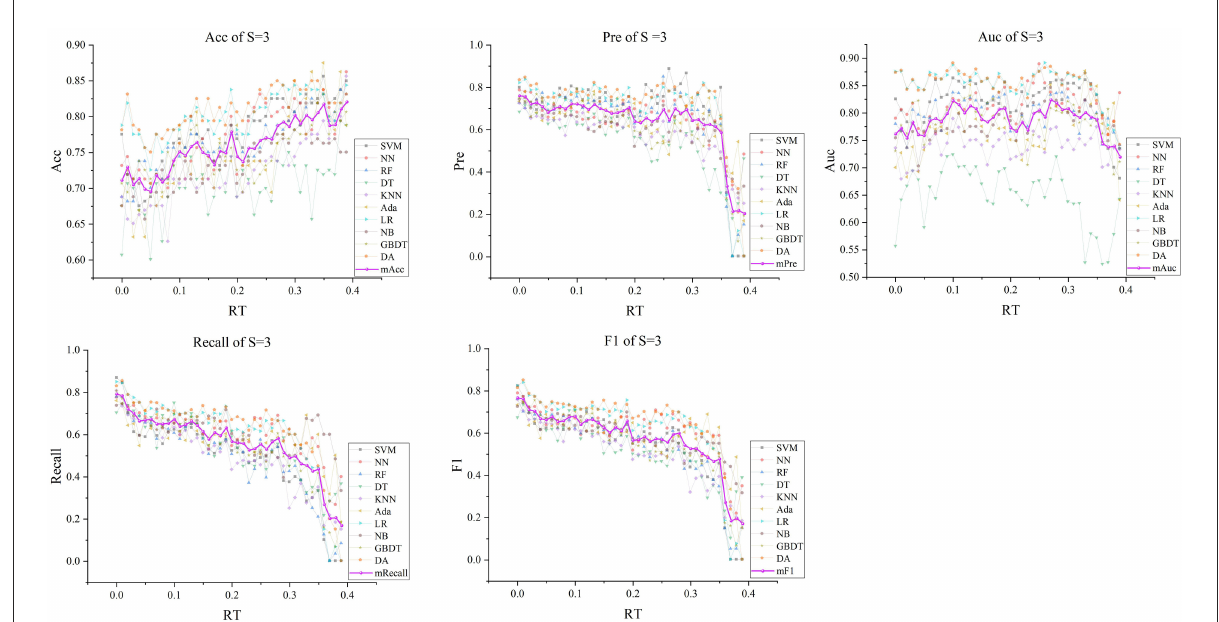
FIGURE6 The five indexes of F ′ RT_S with S = 3 on the ten models, wherein the dark purple lines represent the mean indexes (mAcc, mPre, mAuc, mF1, mRecall), and the other colors represent the performance of the ten models.